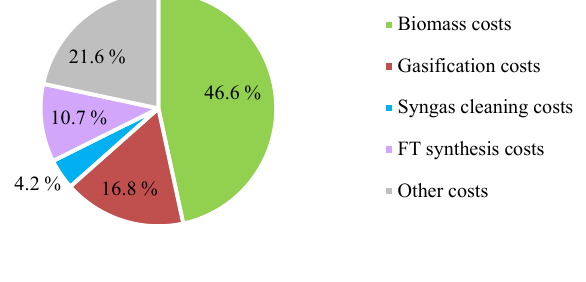
Fig. 3. Breakdown of production